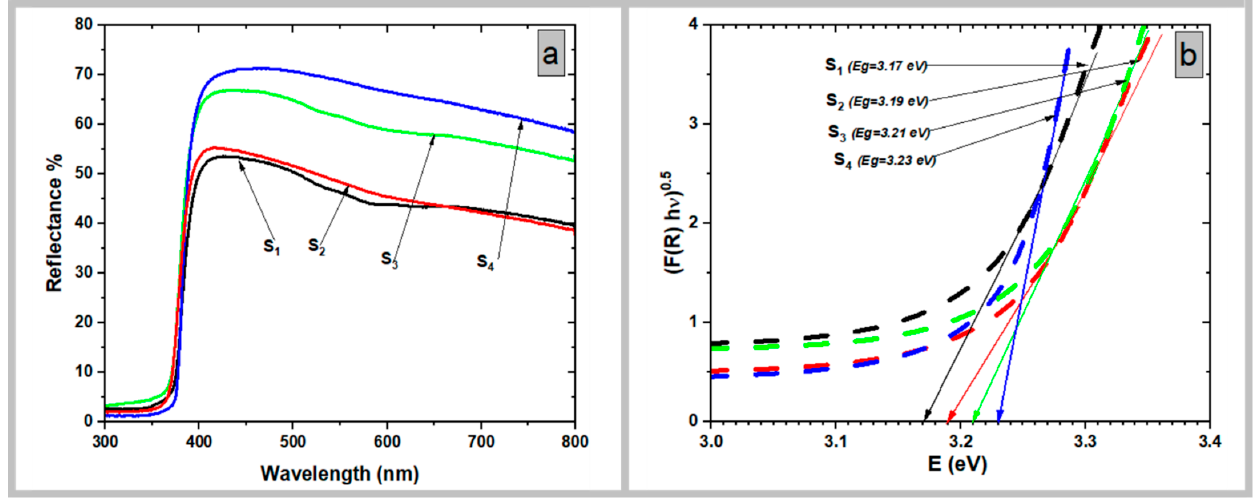
Figure 6. ( a ) UV–Vis diffusion reflection spectra for samples S 1 , S 2 , S 3 , and S 4 . ( b ) (F(R)h υ ) 0.5 versus E (eV) and corresponding fitting line for samples S 1 , S 2 , S 3 , and S 4 .